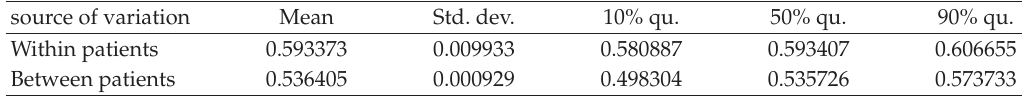
Figure 3: Autocorrelations of fixed e ff ects and parameters for time (cid:3) a,b (cid:4) and mixing behavior of the estimate for gender and one time parameter (cid:3) c,d (cid:4) . Table 1: Estimates of variance